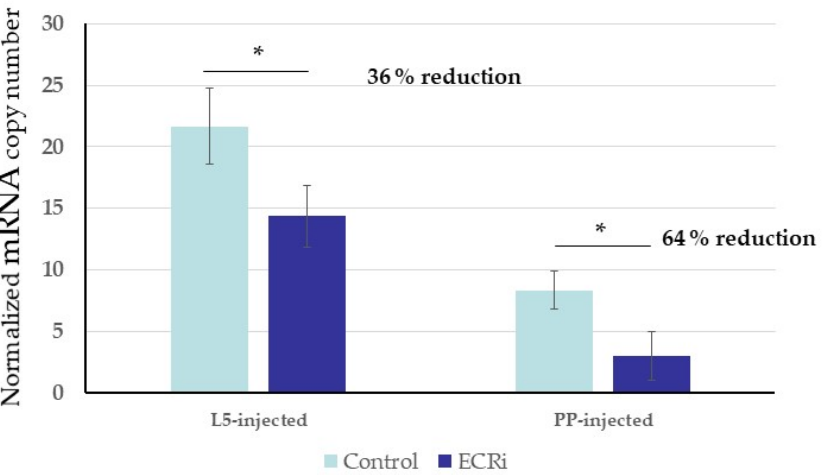
Figure 2. Real time RT-PCR analysis of SnEcR mRNA levels normalized against the Snb-Tub in a pool of 15 randomly selected 5th instar larvae (L5) and prepupae (PP) injected with either the dsEcR 427 (EcRi) or control (dsL4440) three days post injection. Data represent ± SD of 3 biological replicates of a pool of 15 insects each × 3 technical replicates. Statistical differences were performed for EcRi against control treatments using Student’s t-Test (* <0.05).